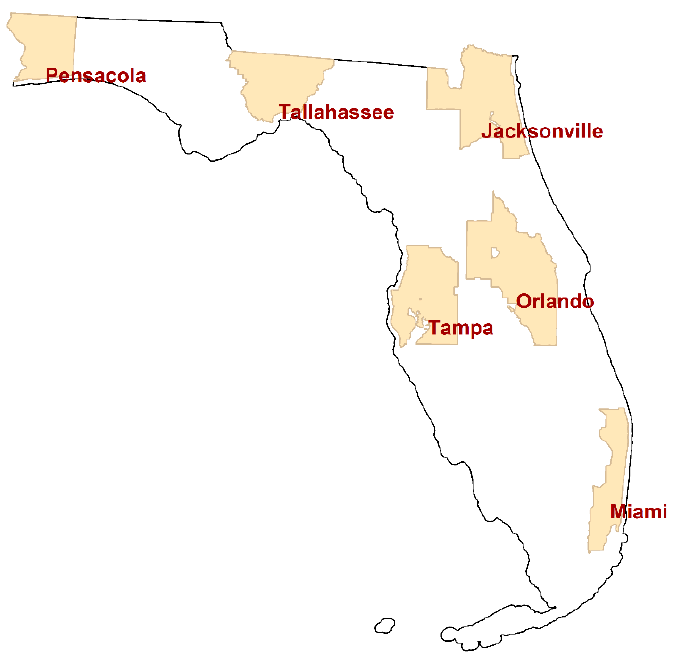
Figure 2. The State of Florida, and the locations of the six studied metropolitan statistical areas (MSAs).